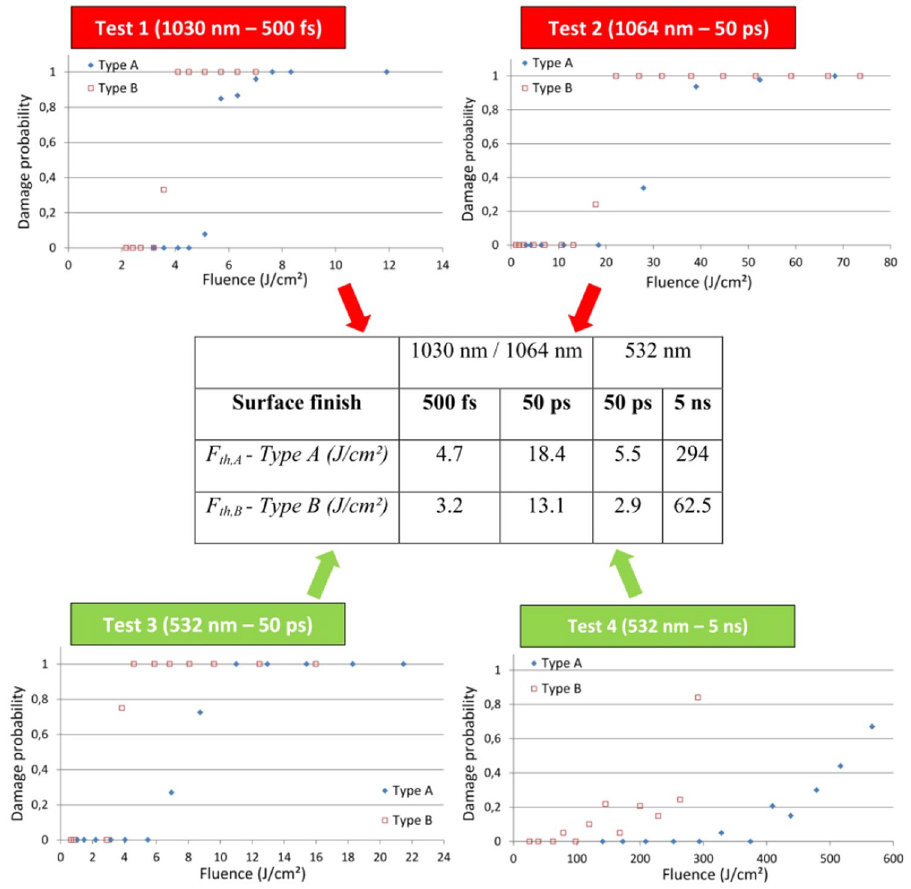
Figure 2. LIDT Measurements. Damage probability curves under various irradiation conditions and in single shot regime obtained for two kinds of Sapphire samples only differing by their surface topography as a result of the different procedures of surface preparation. Each point is averaged on 20 independent tests (error bar not shown). The LIDT fluences are recalled in the table in the central